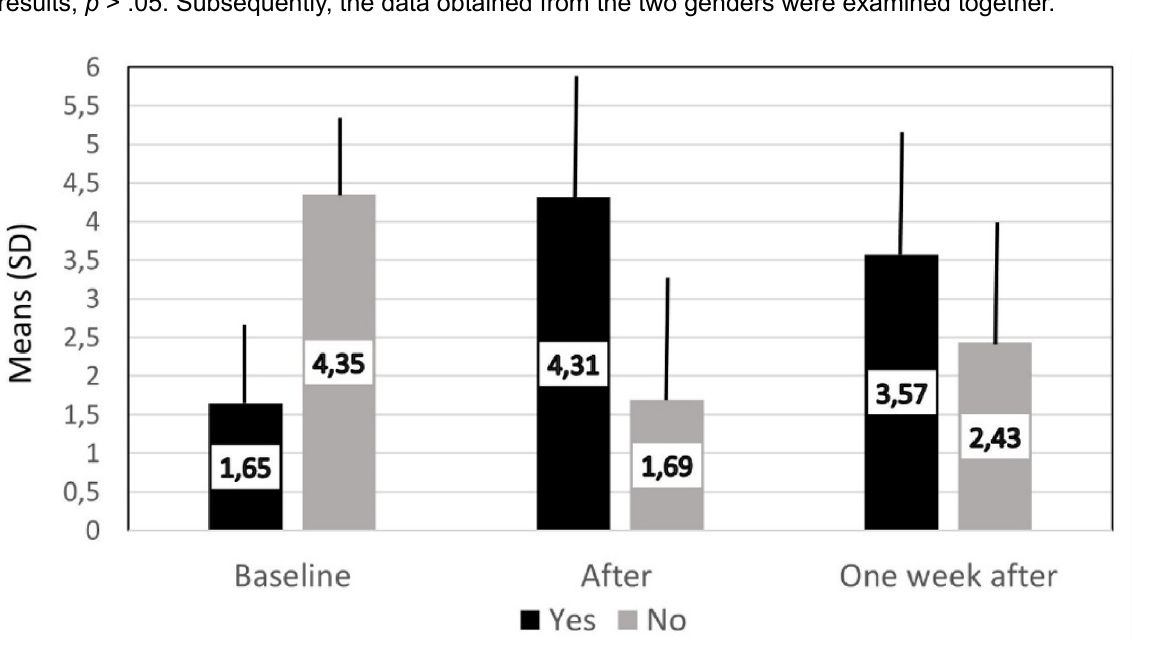
Figure 1. Mean number of ‘yes’ (reflecting agreement) and ‘no’ (reflecting disagreement) answers at baseline, immediately after- and one week after the